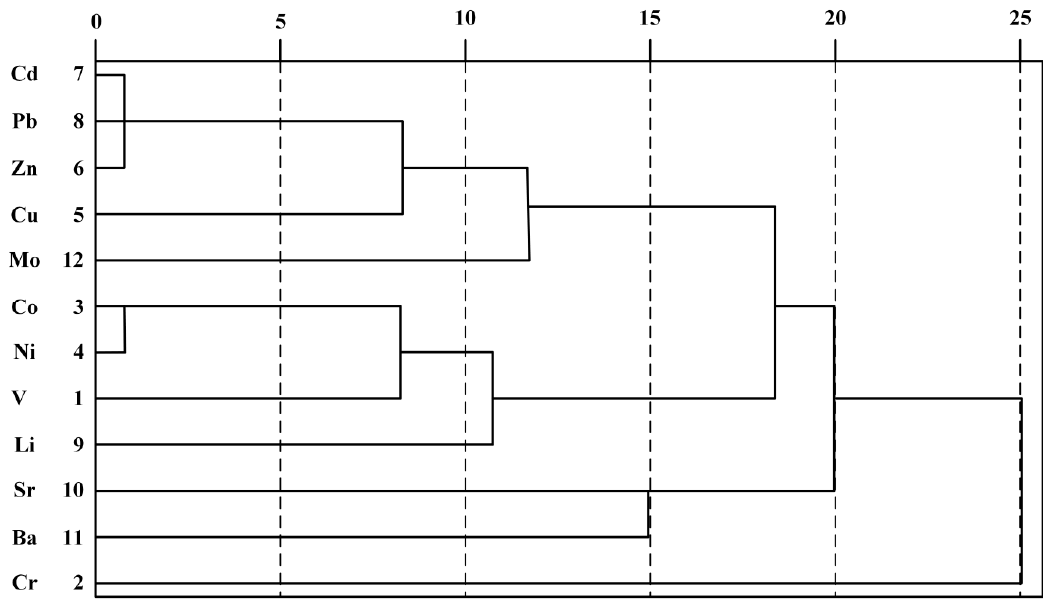
Figure 3. Hierarchical cluster analysis of metals in the topsoil.